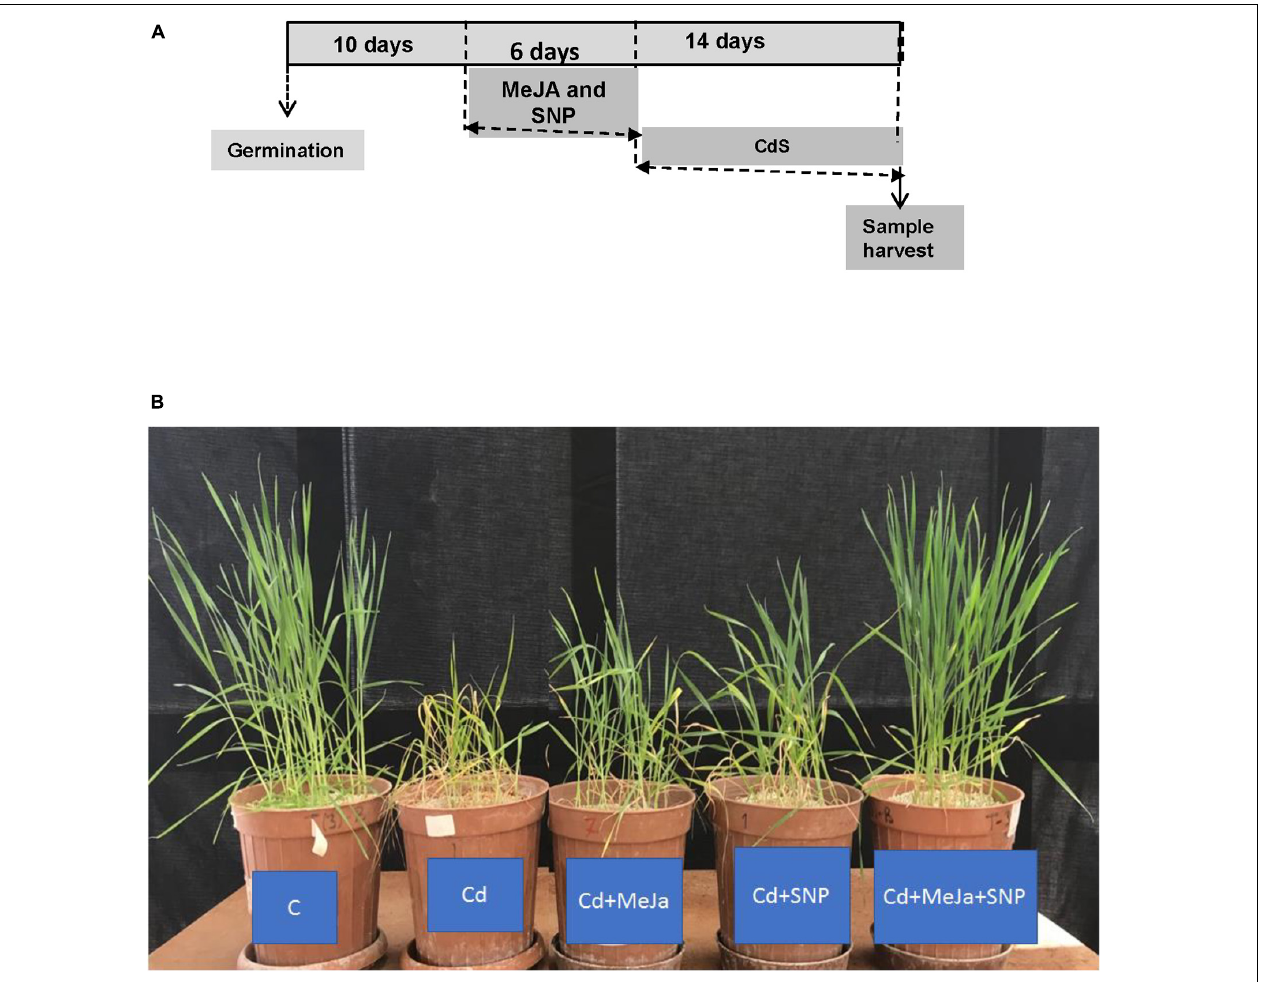
FIGURE 1 | (A) Scheme of the treatments used to study the effect of cadmium (Cd) in wheat plants. The used concentration of each chemical was 100 µ M Cd, 10 µ M methyl jasmonate (MeJA) and 100 µ M sodium nitroprusside (SNP) as nitric oxide donor (NO) and (B) effects of 10 µ M MeJA and MeJA plus 100 µ M SNP on the growth of wheat plants subjected to Cd. Photographs were taken at the end of the